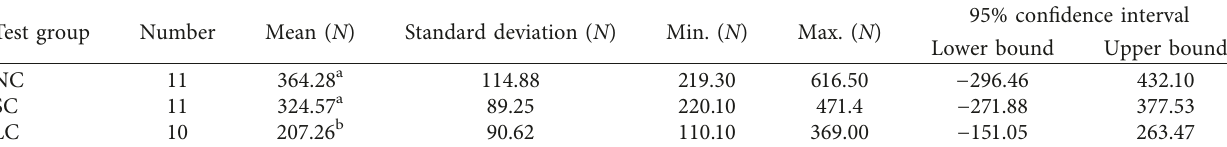
Table 1: The descriptive data for failure load values of test groups.